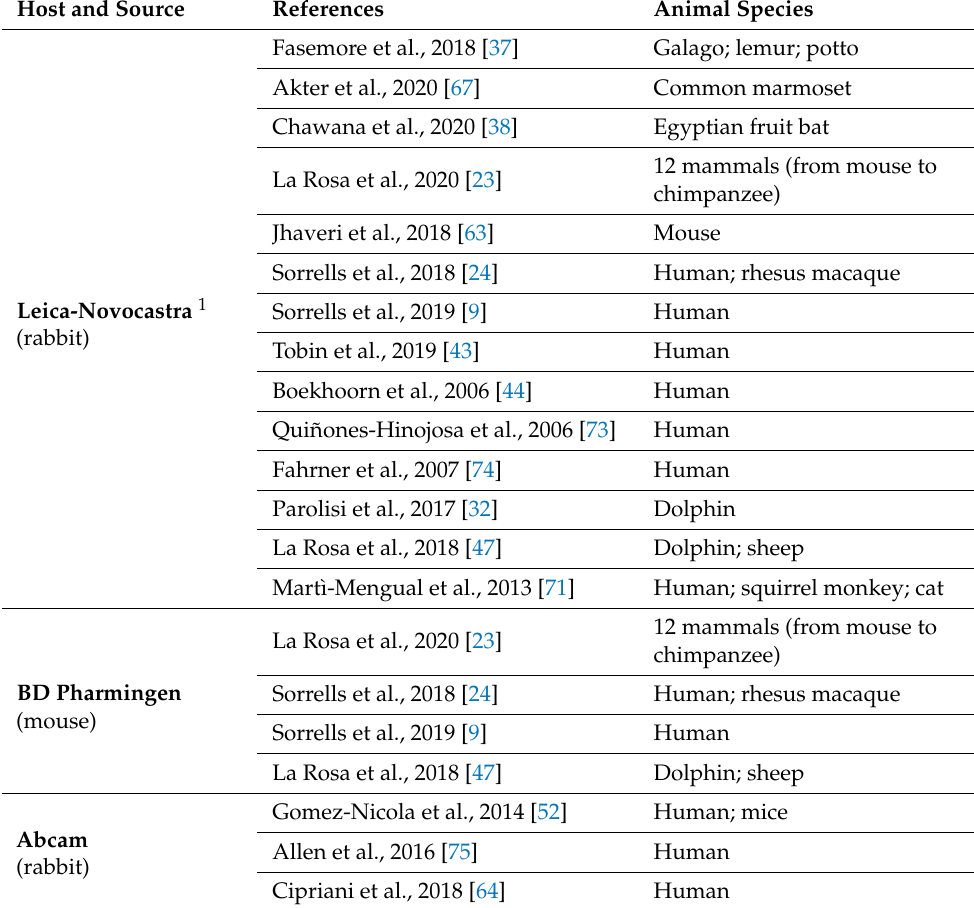
Table 2. Most common antibodies used to detect Ki67 antigen in different